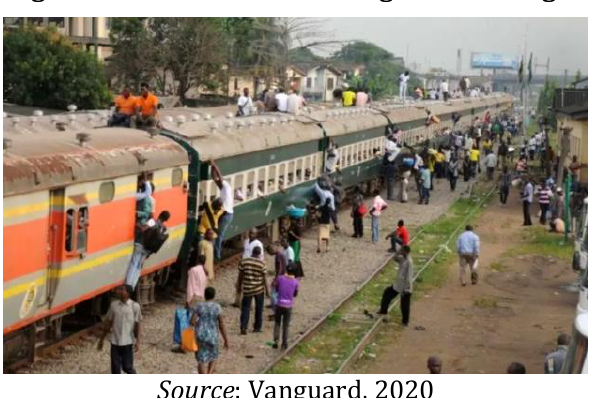
Figure 1: Commuters boarding trains in